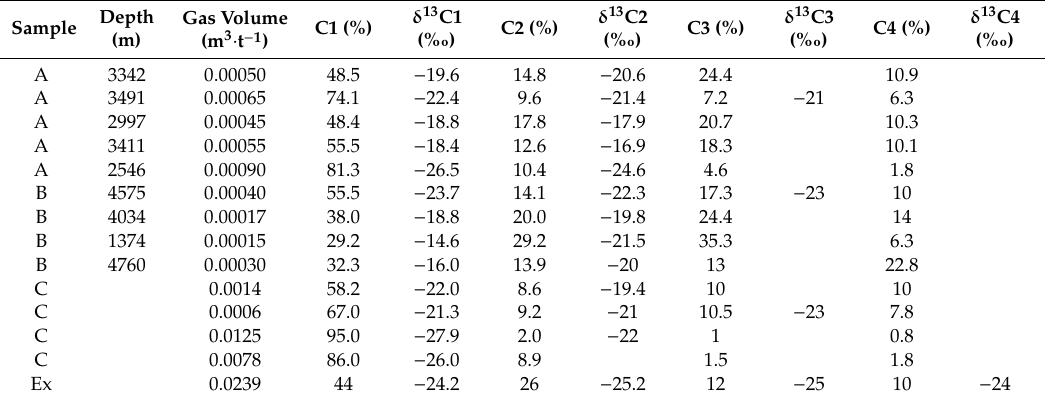
Table 2. Chemical and δ 13 C isotopic composition of gases extracted from the crushed archived shales. Depth Sample (m)